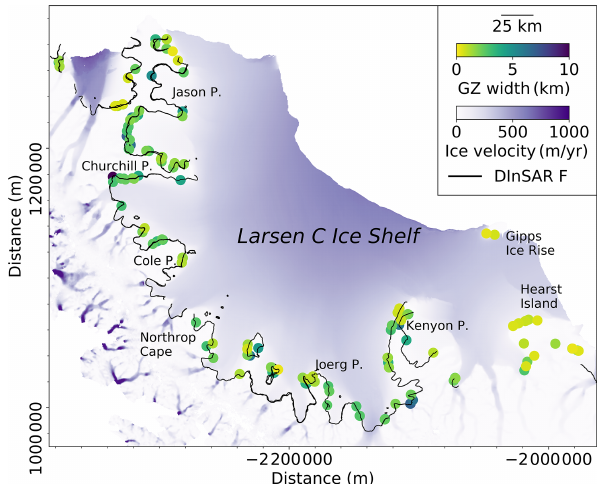
Figure 10. Distributions of GZ width. ESA CCI DInSAR-derived inland limit of tidal flexure (Point F) is shown as the black line (ESA, 2017). Background is the recent ice surface veloc- ity magnitudes (Rignot et al., 2017) in Antarctic polar stereo- graphic (epsg:3031)